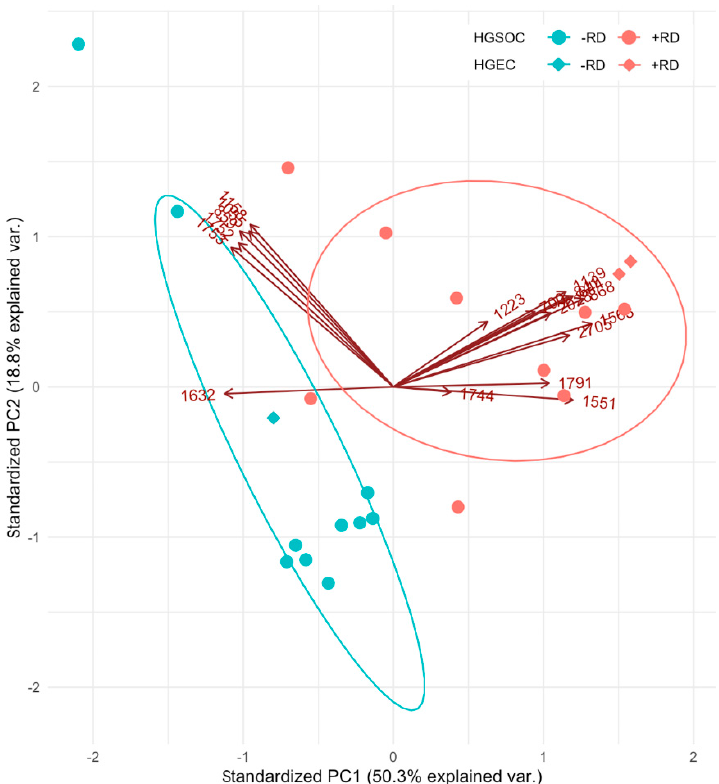
Figure 5. A biplot showing included samples of early-stage HGSOC patients as points. Additionally, three patients with high-grade endometrioid ovarian cancer (HGEC) were included in the analysis and marked with diamonds. Biplot axes indicate the influence of each peptide in the principal component space. The principal component analysis (PCA) shows a discrimination of patients with (+RD) and without recurrent disease ( − RD).